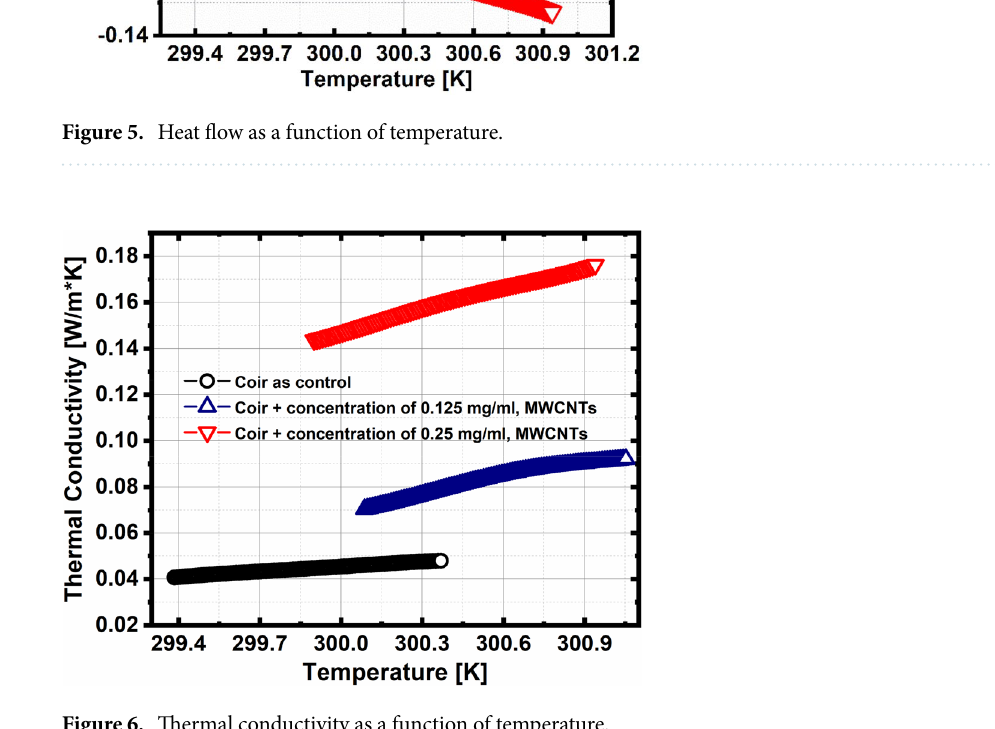
Figure 6. Thermal conductivity as a function of temperature.